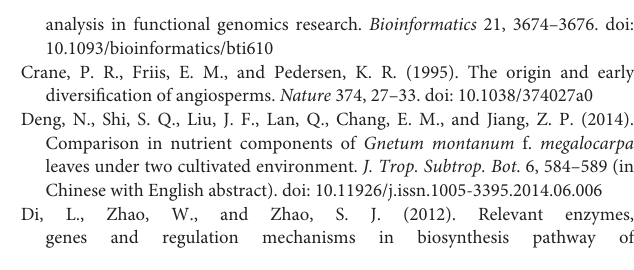
Supplementary Table S9 | Simple sequence repeats (SSRs) in genes involved in secondary metabolism. Supplementary Table S10 | Summary of simple sequence repeats (SSRs) identified in transcripts of Gnetum parvifolium. Repeats of mononucleotides were excluded from the distribution of SSRs in different repeat types. Supplementary Table S11 | Potential STS-like genes discovered in Gnetum parvifolium